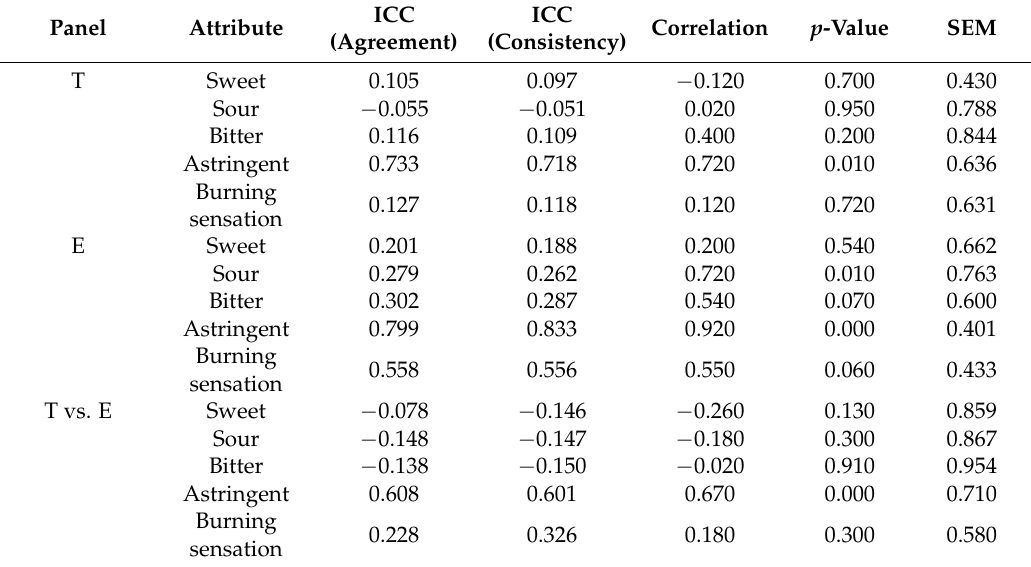
Table 2. Intrapanel reliability